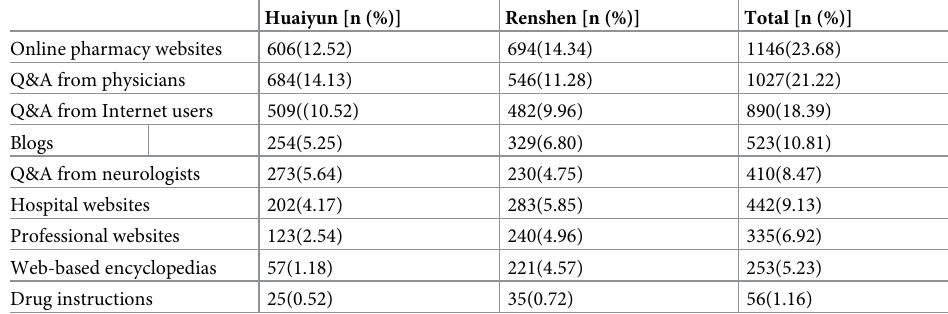
Table 1. Sources of online epilepsy information by different search